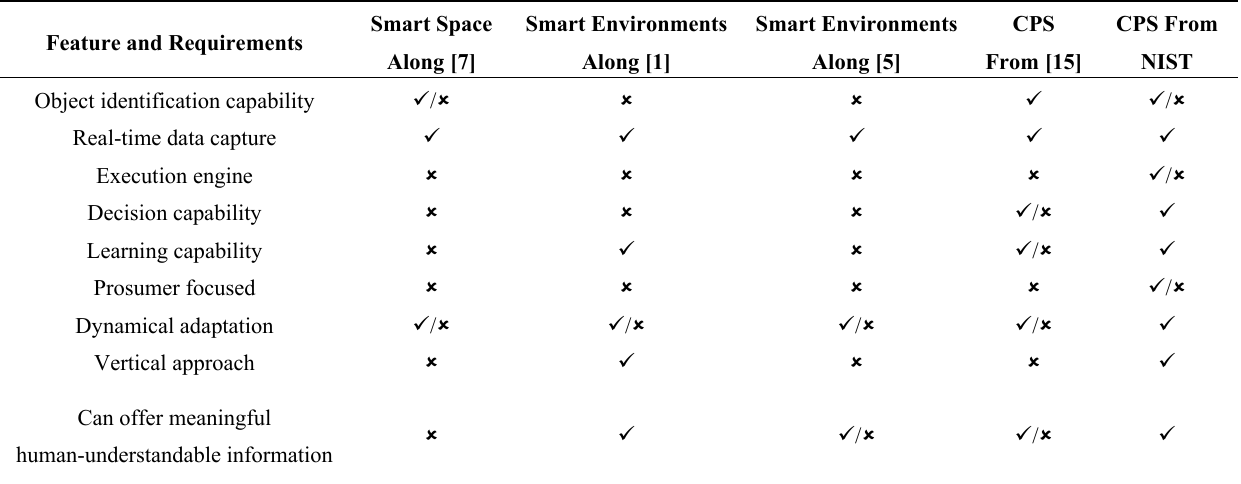
Table 1. Comparison among different theories about networked embedded systems in relation to traceability